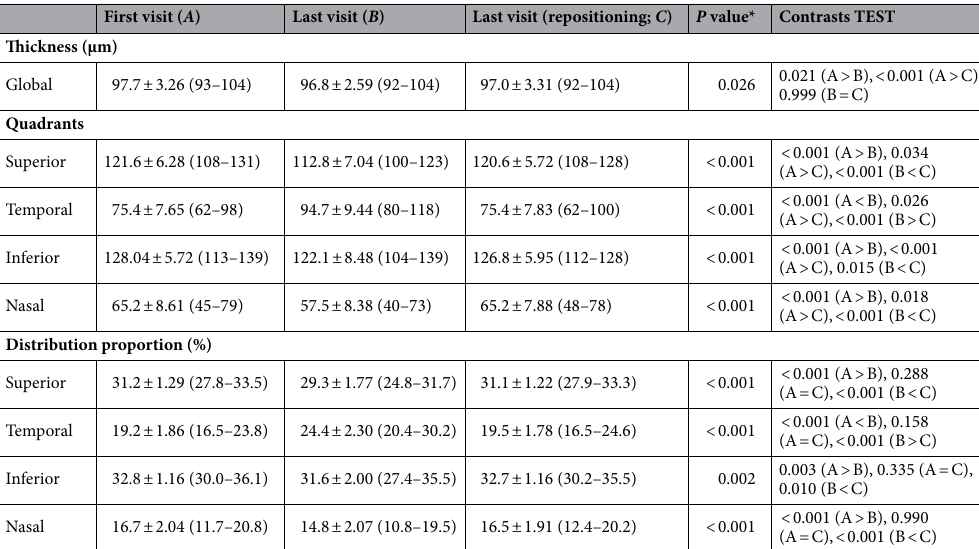
Table 1. Circumpapillary retinal nerve fiber layer thickness and distribution proportions after adjustment of scan-circle location on final optical coherence tomography. Values are mean ± standard deviation (range). Bonferroni correction for multiple comparisons was applied. *Repeated measures ANOVA with Greenhouse– Geisser